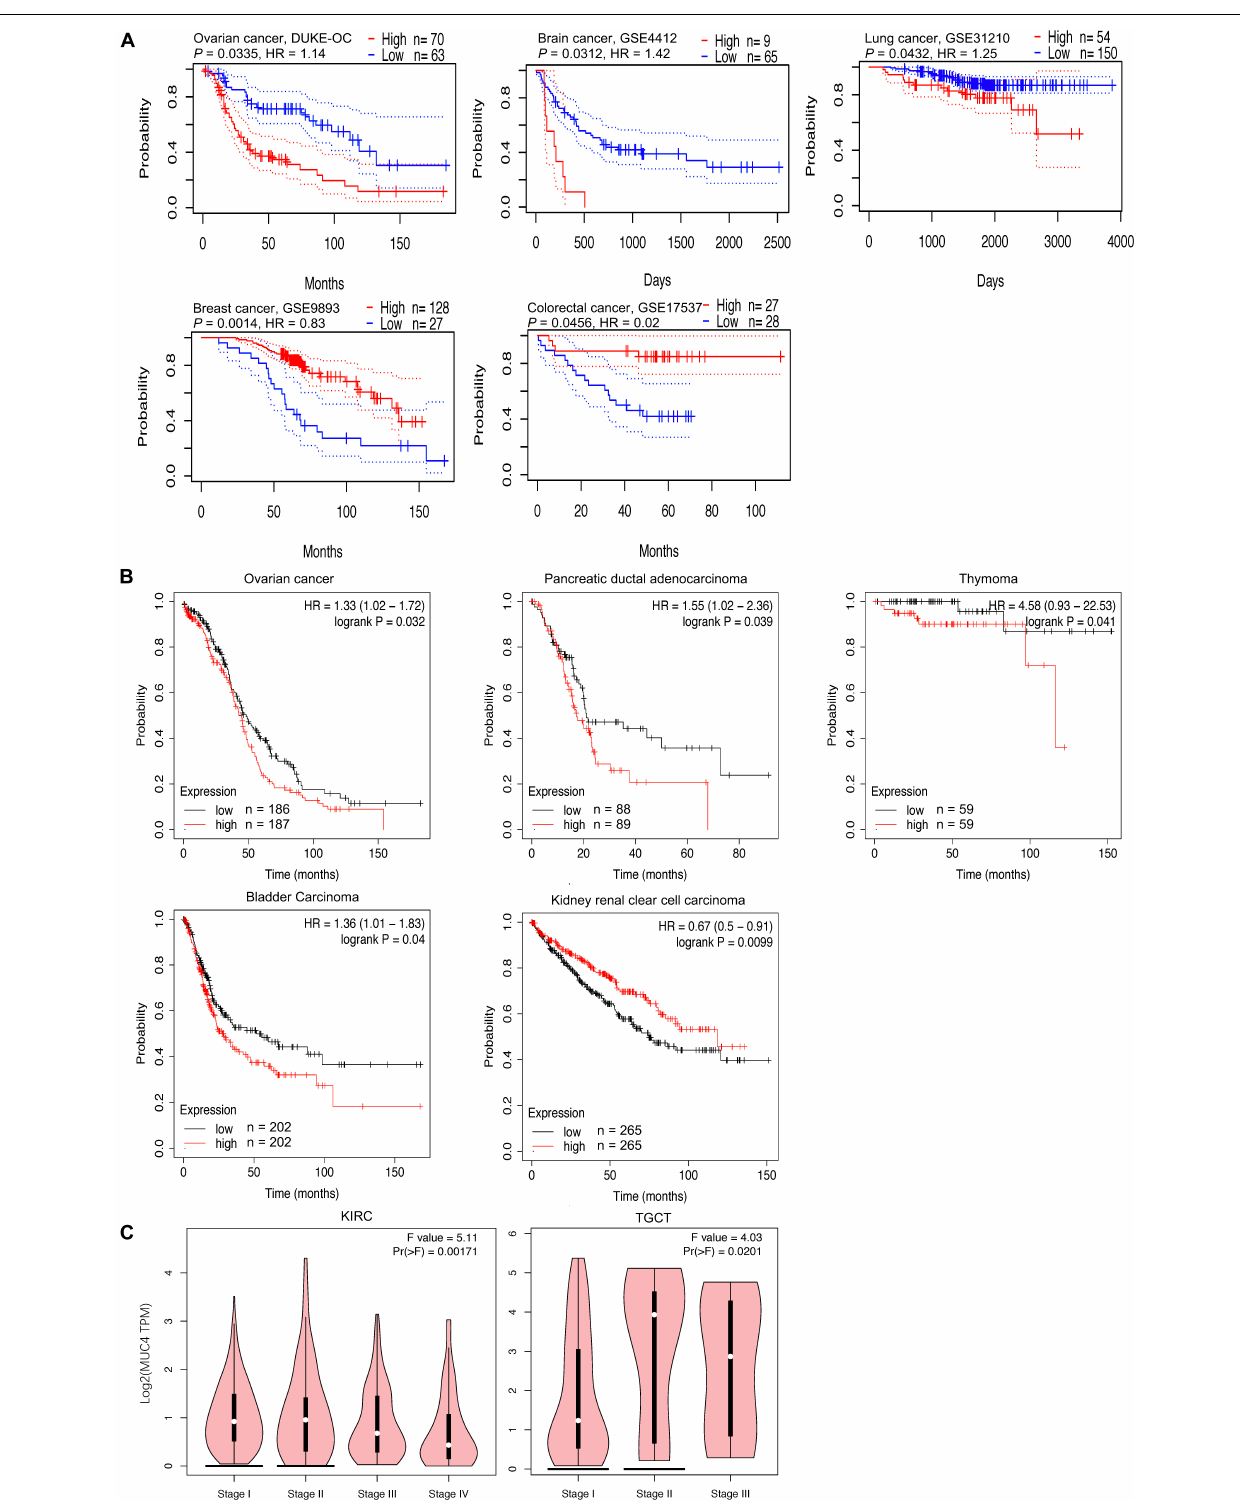
Frontiers in Cell and Developmental Biology | www.frontiersin.org